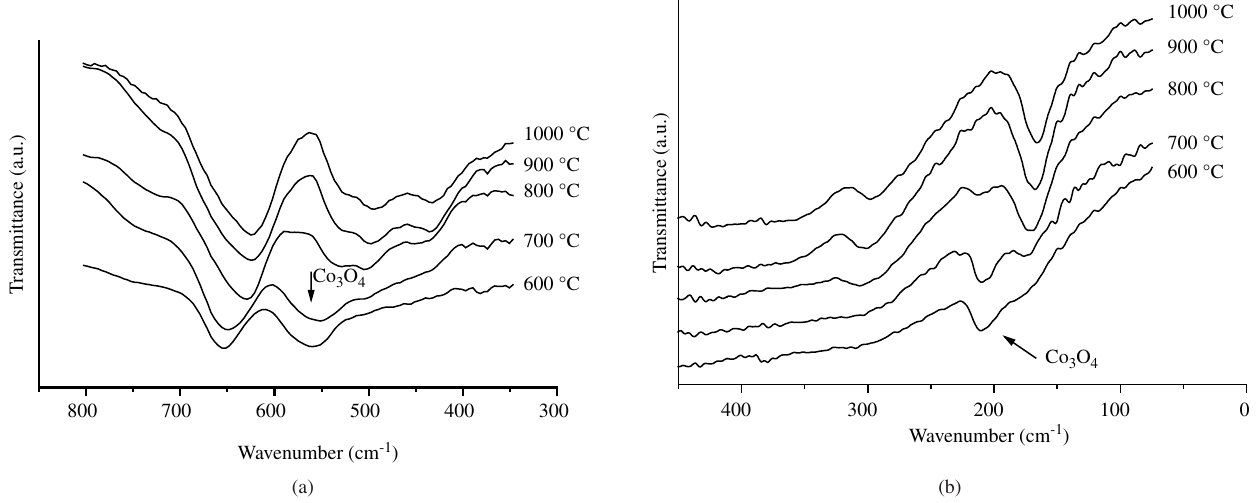
Sb O calcined at 600 to 1000 °C: a) frequency range of 800 to 400 cm -1 ; b) frequency range of 400 to 7 2 12